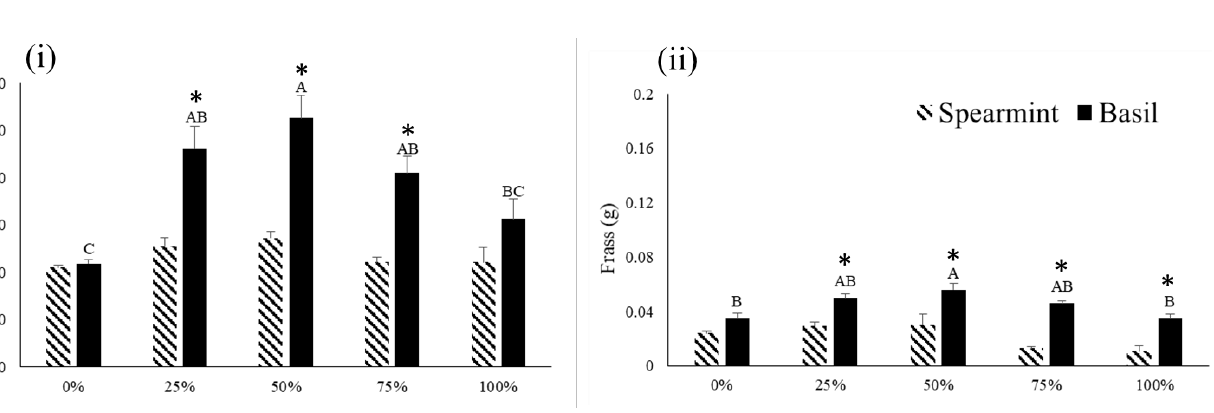
Figure 3. Mean ± of progeny production ( i ) and frass ( ii ) of Oryzaephilus surinamensis. Within each fortification (rice fortified with spearmint or basil) means followed by the same uppercase letter are not significantly different (Tukey-Kramer HSD test at 0.05). Where no letters exist, no significant differences were noted. Within each treatment, means with asterisks (*) indicate significant differences between the two fortified commodities (spearmint and basil) tested according to Student’s t -test at 0.05. t -test parameters for progeny production at 25% were t = 16.422, p = 0.001; at 50% were t = 25.05, p = 0.001; and at 75% were t = 27.0, p < 0.001. For frass, t -test parameters at 25% were t = 19.102, p < 0.01; at 50% were t = 6.173, p = 0.026; at 75% were t = 109.08, p < 0.001; and at 100% were t = 14.226, p = 0.002. In all cases, df total = 39.